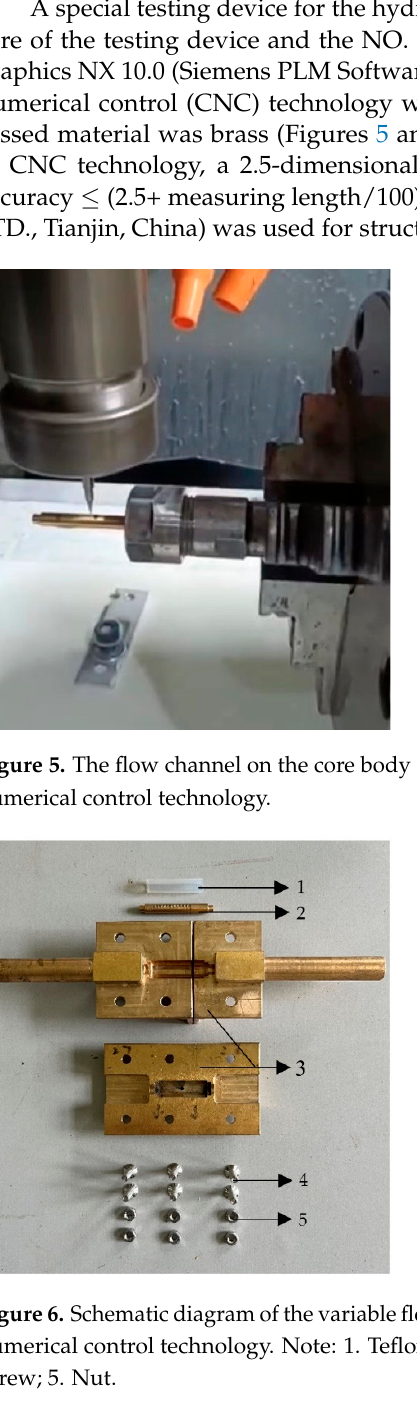
Figure 7. Hydraulic performance test platform for variable flow emitter. Note: 1. Water storage tank ; 2. Centrifugal pump ; 3. Filter ; 4. Ball valve ; 5. Pressure gauge ; 6. Valve ; 7. Special testing device ; and 8. Bucket. 2.3. The Numerical Simulation